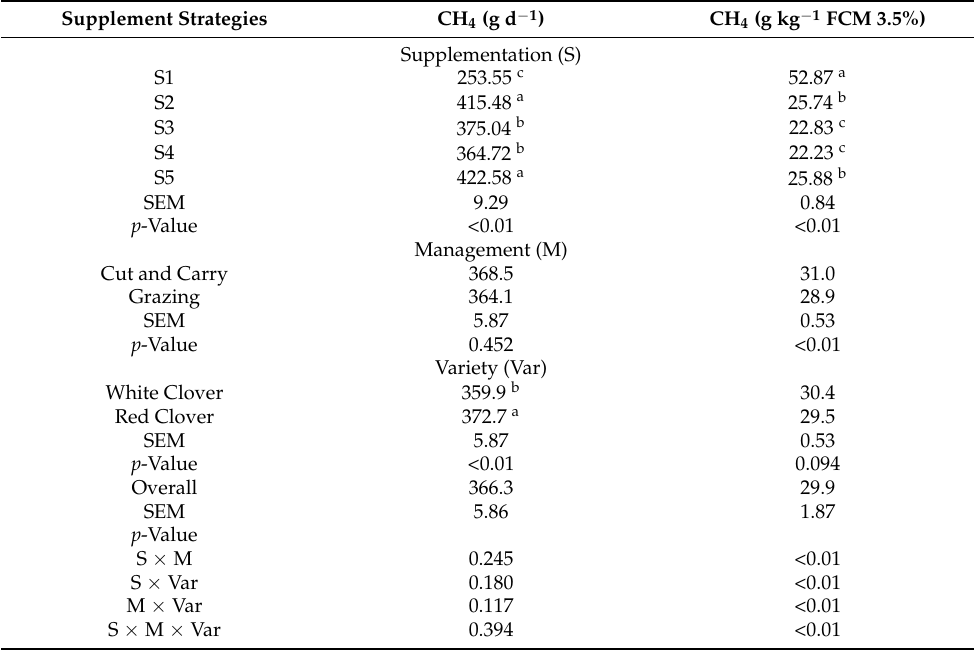
Table 7. Emissions of methane (CH 4 )) of different strategies, five different supplementations (S) in dairy cattle under two feeding strategy management systems (grazing vs. cut-and-carry), and two legumes varieties (red clover or white clover). Supplement